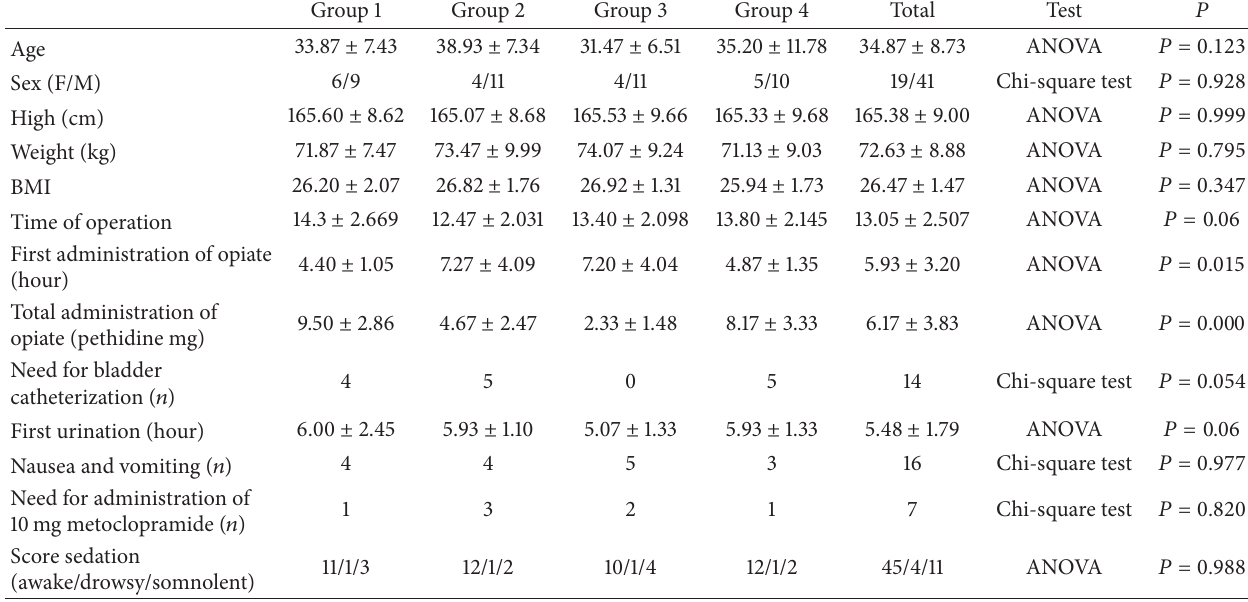
Table 2: Studied variables.